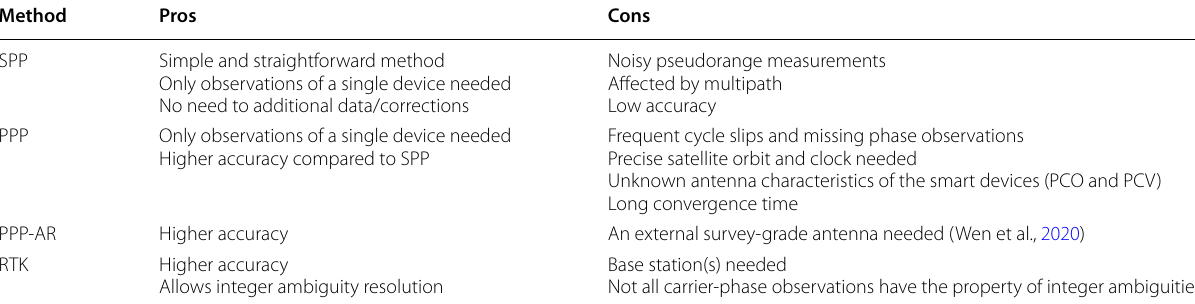
Table 5 Pros and cons of smartphone positioning using different methods Method Pros Cons SPP Simple and straightforward method Only observations of a single device needed